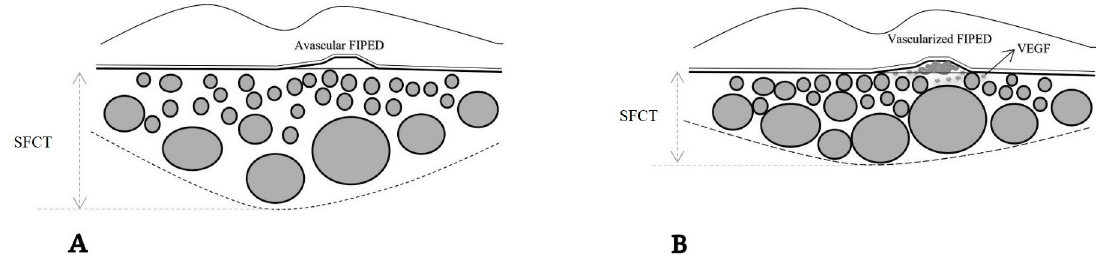
Fig 2. Choroidal features in patients with aFIPED (A) showed greater choroidal thickness and choroidal area, and lower CVI in comparison to vFIPED (B). Dilated pachyvessels impose a mechanical pressure on choriocapillaris which subsequently causes attenuation of the inner choroid, VEGF production (stars), and new vessel formation. SFCT: Subfoveal choroidal thickness, FIPED: Flat irregular pigment epithelial